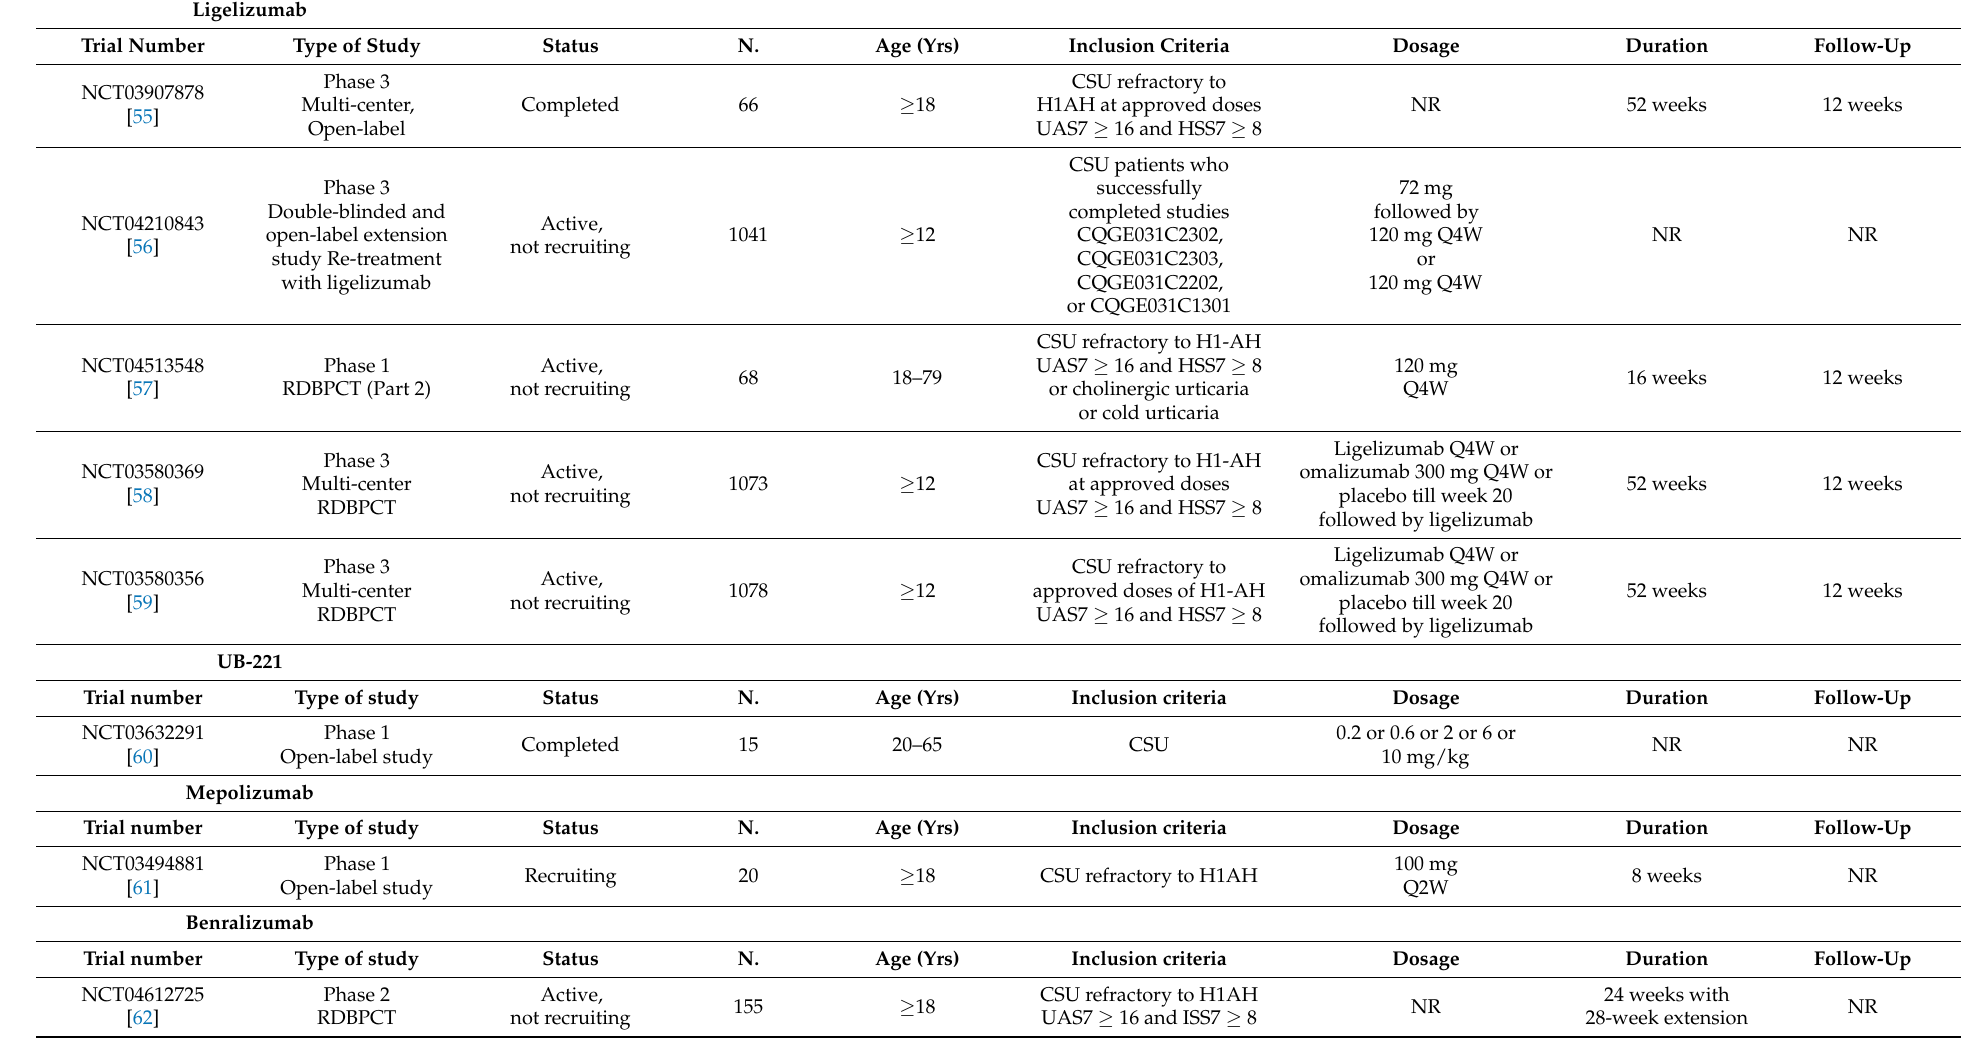
Table 5. List of the ongoing trials investigating mAbs in treating